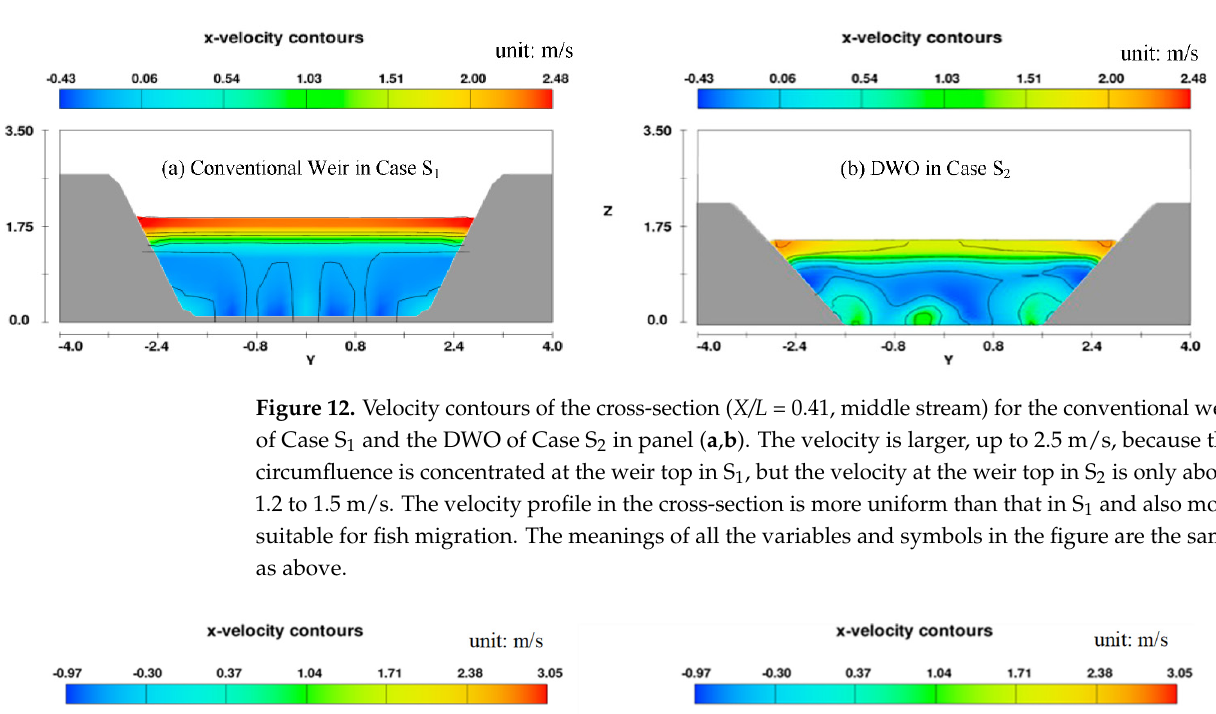
Figure 13. V elocity contours of the cross-section ( X/L =0.75, downstream) for the conventional weir of Case S 1 and the DWO of Case S 2 in panel ( a , b ). As the height of the downstream weir is very small, the depth is also largely decreased, which causes the turbulence intensity of the flow to increase. However, the water surface fluctuation and the velocity of the overflow at the weir top in S 2 are both less than those in S 1 . The meanings of all the variables and symbols in the figure are the same as above.